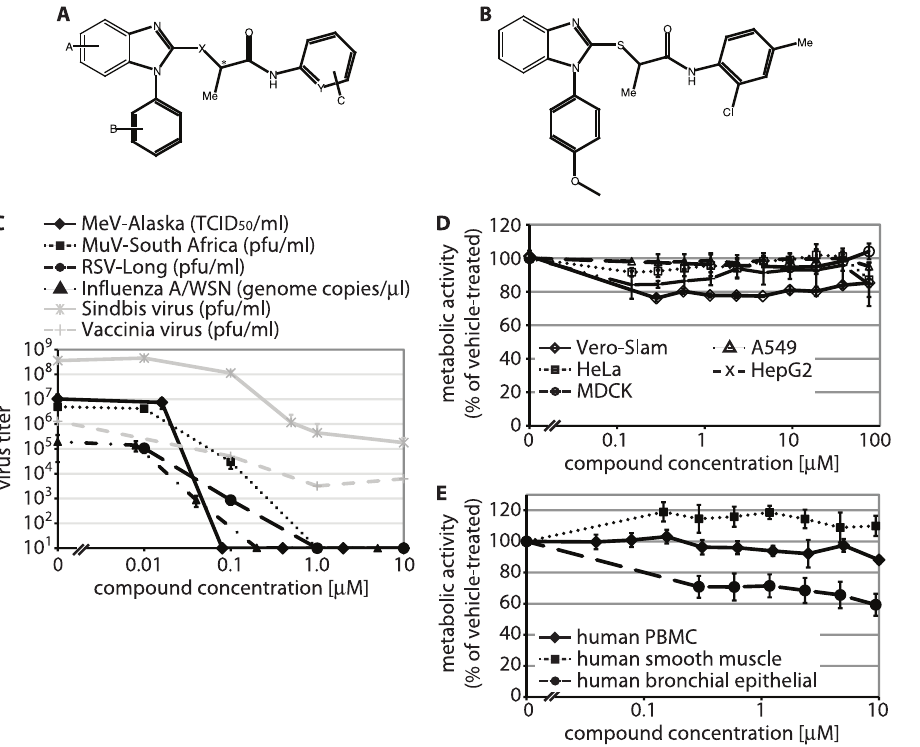
Figure 1. Identification of a chemical scaffold with broad anti-myxovirus activity. Chemical structures of the identified scaffold ( A ) and the current lead analog JMN3-003 ( B ). C ) Dose-response curves for JMN3-003 and MeV-Alaska, MuV-South Africa, RSV Long, influenza A/WSN (H1N1), sindbis virus and vaccinia virus. Titers of cell-associated progeny viruses were determined by TCID 50 titration (MeV) or plaque assay (MuV, RSV, sindbis virus, vaccinia virus). For influenza virus, genome copy numbers of released progeny particles were quantified through TaqMan RT-PCR. Titers of released sindbis virus particles were determined by plaque assay. Values reflect averages of at least three experiments 6 SD, vaccinia virus titers were determined in duplicate. D and E ) Assessment of metabolic activity of cells after incubation of different established cell lines (D) or primary human cells (E) in the presence of JMN3-003 for 24 hours. Results for human (HeLa, A549, HepG2), primate (Vero-Slam), and canine (MDCK) cell lines and primary human cells (PBMC, smooth muscle, bronchial epithelial) are shown. Values reflect averages of four replicates 6 SD.